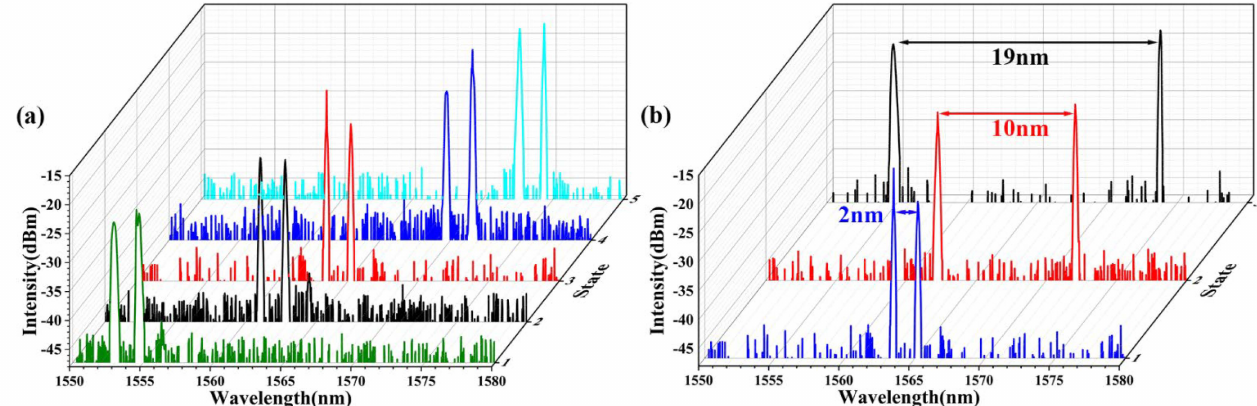
Figure 4. Wavelength tunable operations by rotating the PCs: ( a ) the adjustable central wavelength; ( b ) the adjustable wavelength